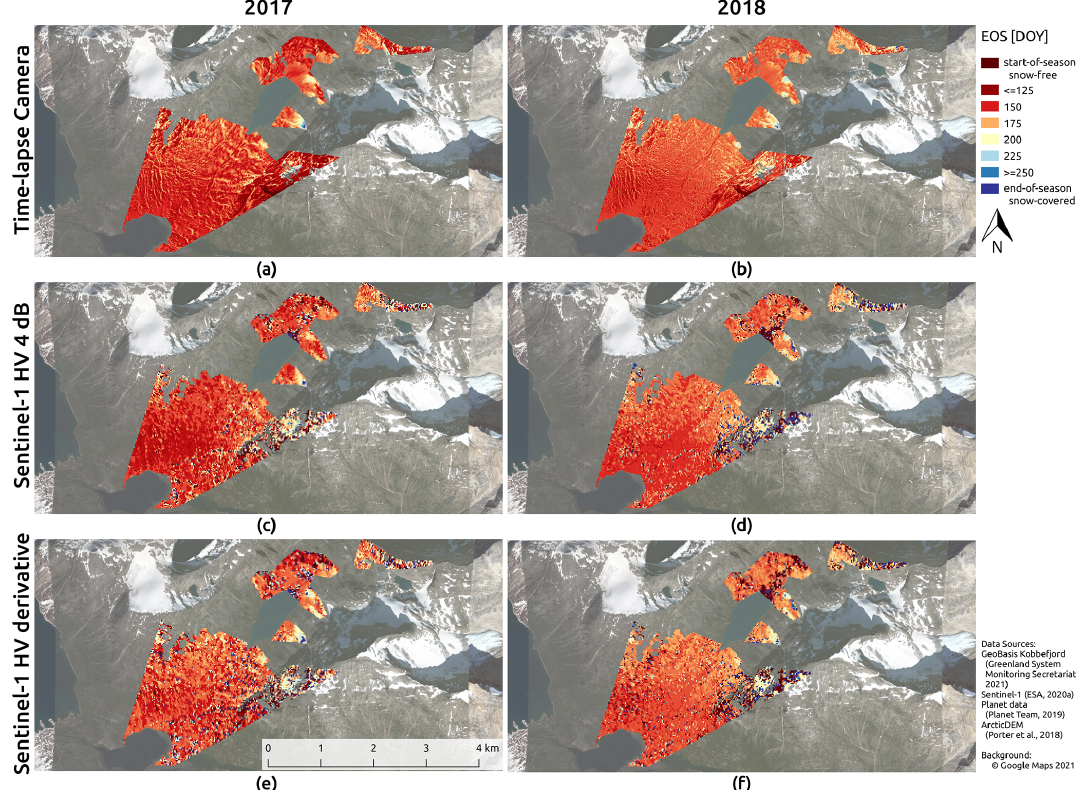
Figure 12. Melt layers of Kobbefjord: (a–b) reference product by the time-lapse imagery reference; subset of the S-1 product (c–d) with global parameter configuration and (e–f) with the derivative